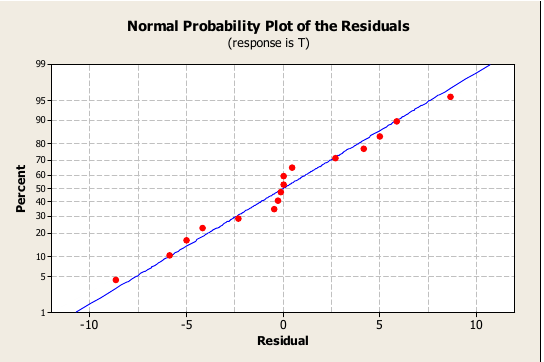
Fig. 2. Normal probability plot of the residuals Fig. 3. Anderson Darling test for normality for cutting temperature